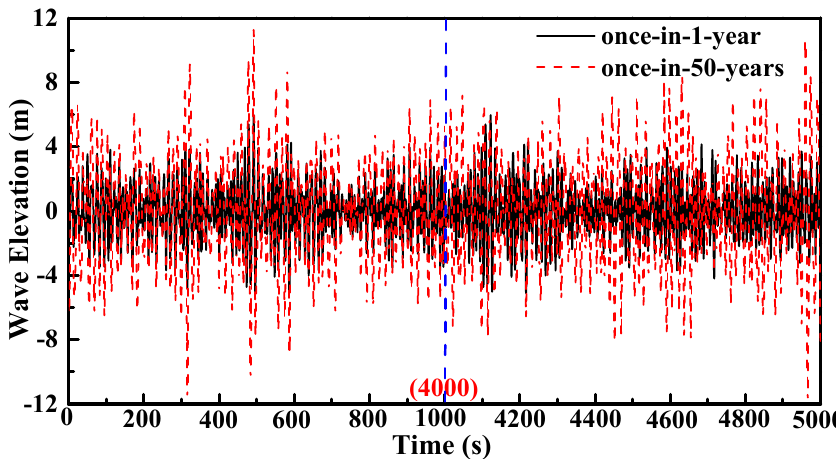
Figure 12. Time series of wave elevation under extreme sea-states.